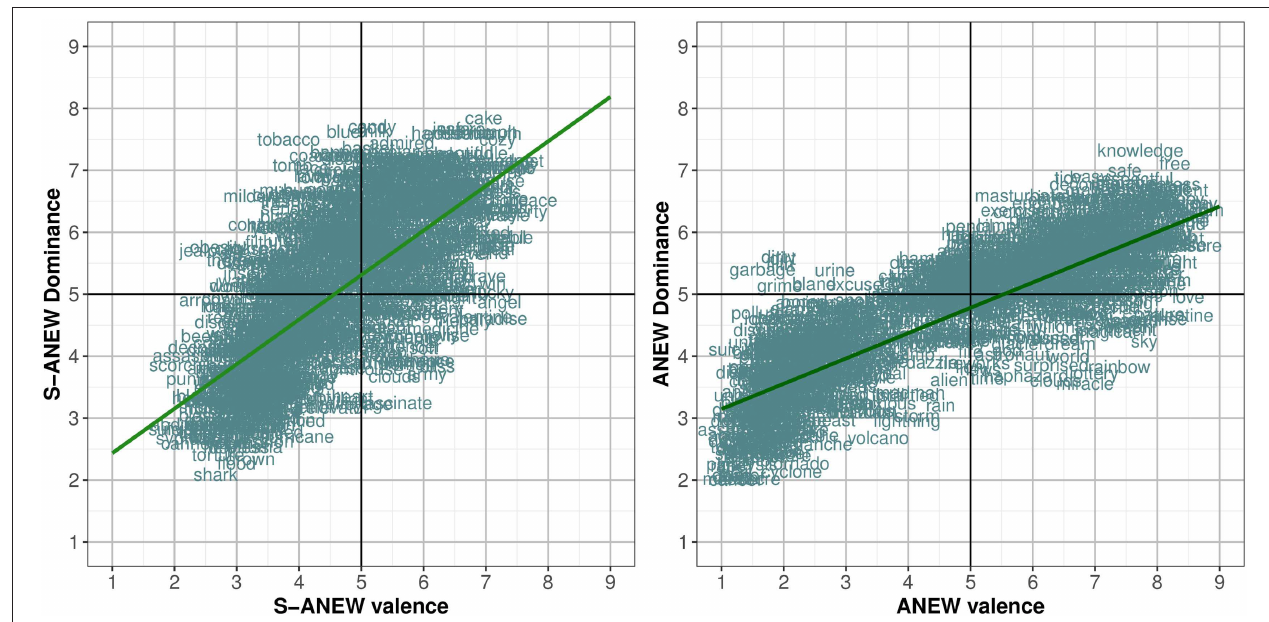
FIGURE 4 | Distribution of the mean values corresponding to the suspense ratings of the 1,034 words in the dimensions of valence and